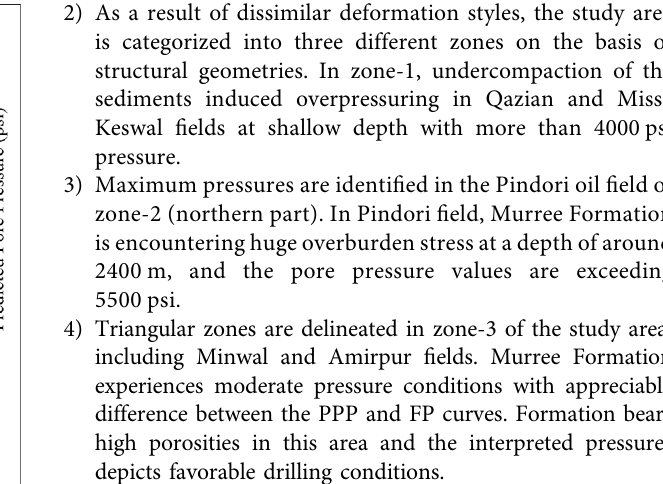
FIGURE 15| Relationship between acoustic velocity(y-axis) and vertical effectivestress(x-axis)inQazian-1Xwell.Dataplotrepresentsthemechanism of overpressuring in Murree Formation due to the undercompaction of sediments. Overpressure (blue) and underpressure (green) zones show an opposite trend as the velocity and effective stress both are decreasing in the overpressure zone indicating undercompaction of sediments. In the underpressurezonethereisanincreaseinvelocity,whichrepresentsanormal compaction